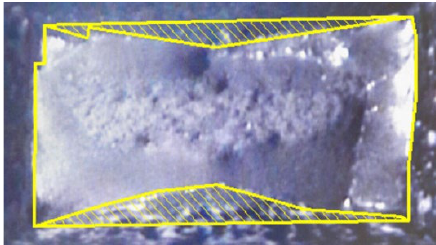
Figure 7. Assessment of the effective resisting area at failure for the DP1000-S test.